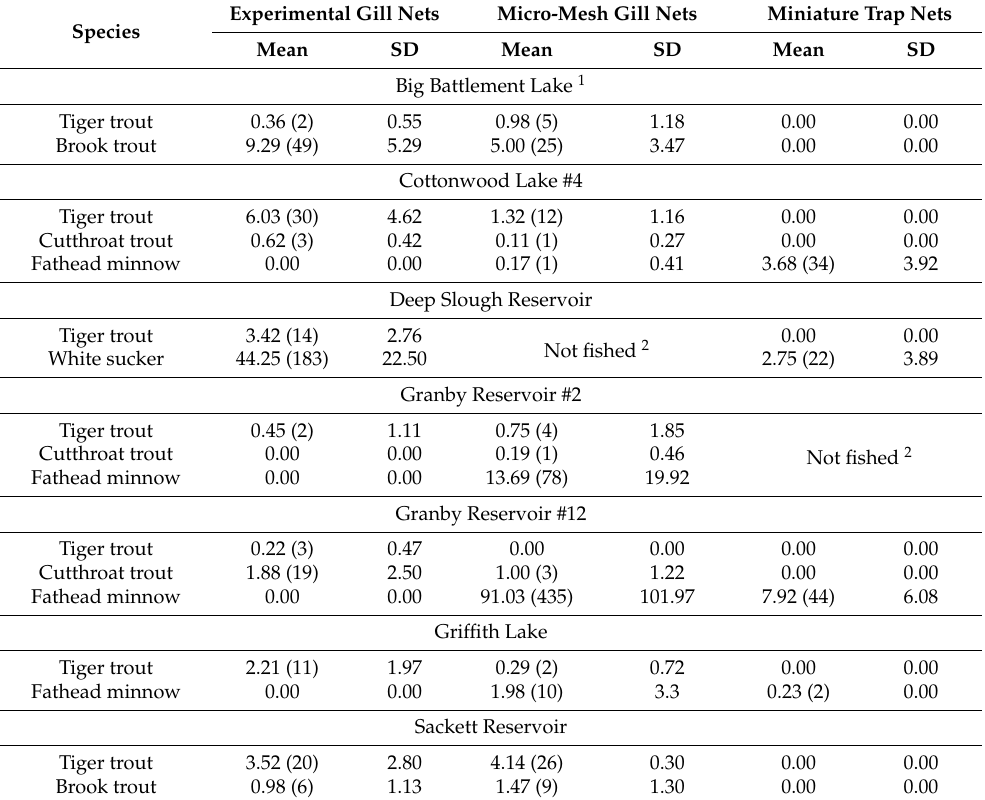
Table 3. Catch rates (means and SDs; number fish/hour; index of relative abundance) of tiger trout, cutthroat trout, and other undesirable fishes (brook trout, fathead minnow, and white sucker) captured in different sampling gears in each study system. Values in parentheses represent the total number of fish encountered in each